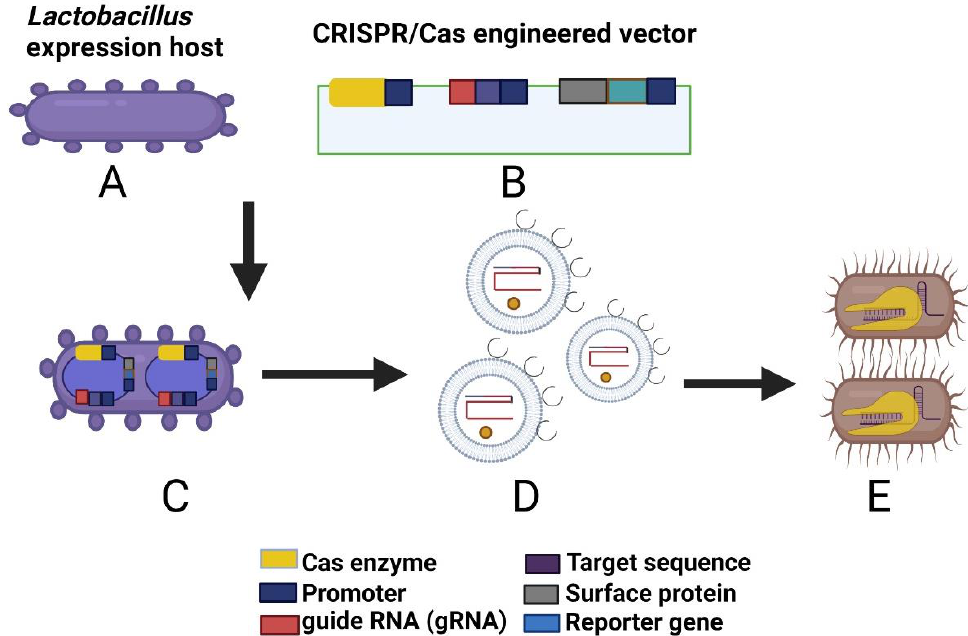
Figure 2. Application of the CRISPR/Cas system for the development of biotherapeutic tools against infections crossing the BBB. ( A ) Lactobacillus expression host, ( B ) CRISPR/Cas expression vector, ( C ) expression of the engineered vector in Lactobacillus , ( D ) CRISPR/Cas-enriched Lactobacillus bEV, and ( E ) targeted therapy against pathogenic bacteria via surface protein receptors. The figure was created using BioRender.com (https://app.biorender.com; accessed on 3 November 2022).